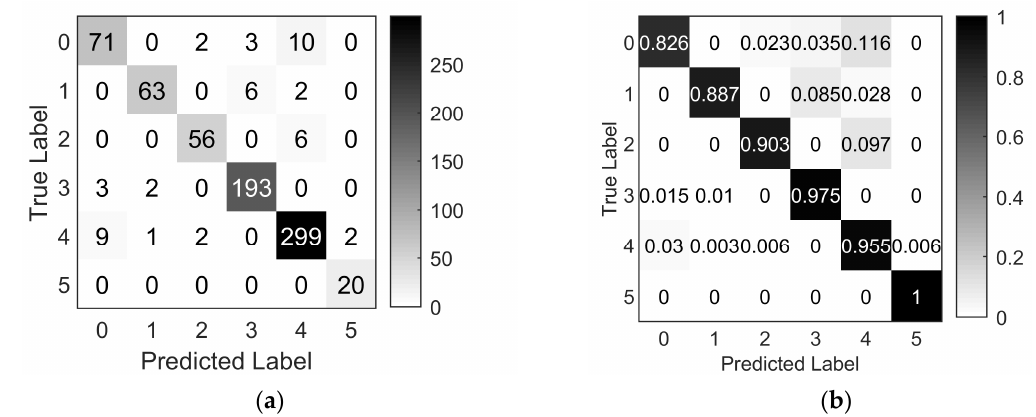
Figure 16. Confusion matrix and its normalization of the proposed method using the VAIS dataset. Note that numbers 0–5 denote medium-other, merchant, medium-passenger, sailing, small, and tug ship types, respectively; ( a ) confusion matrix; and ( b ) confusion matrix normalization.